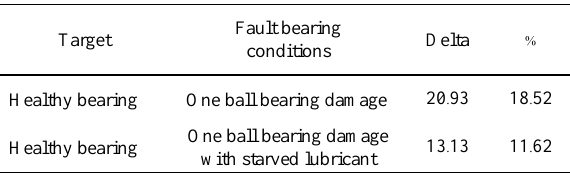
Table 3 . Comparison of between heathy bearing and fault bearing conditions .